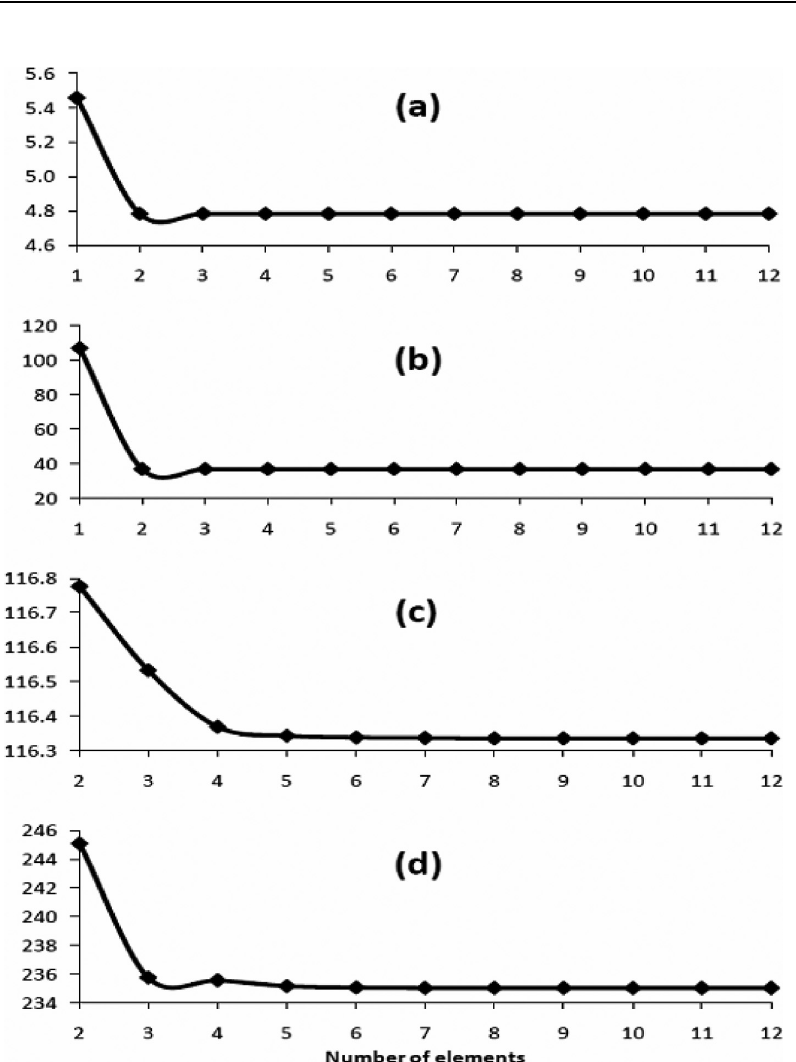
Fig. 11. Convergence of natural frequencies of a C-F unsymmetric tapered arch: (a) fi rst mode, (b) second mode, (c) third mode and (d) fourth